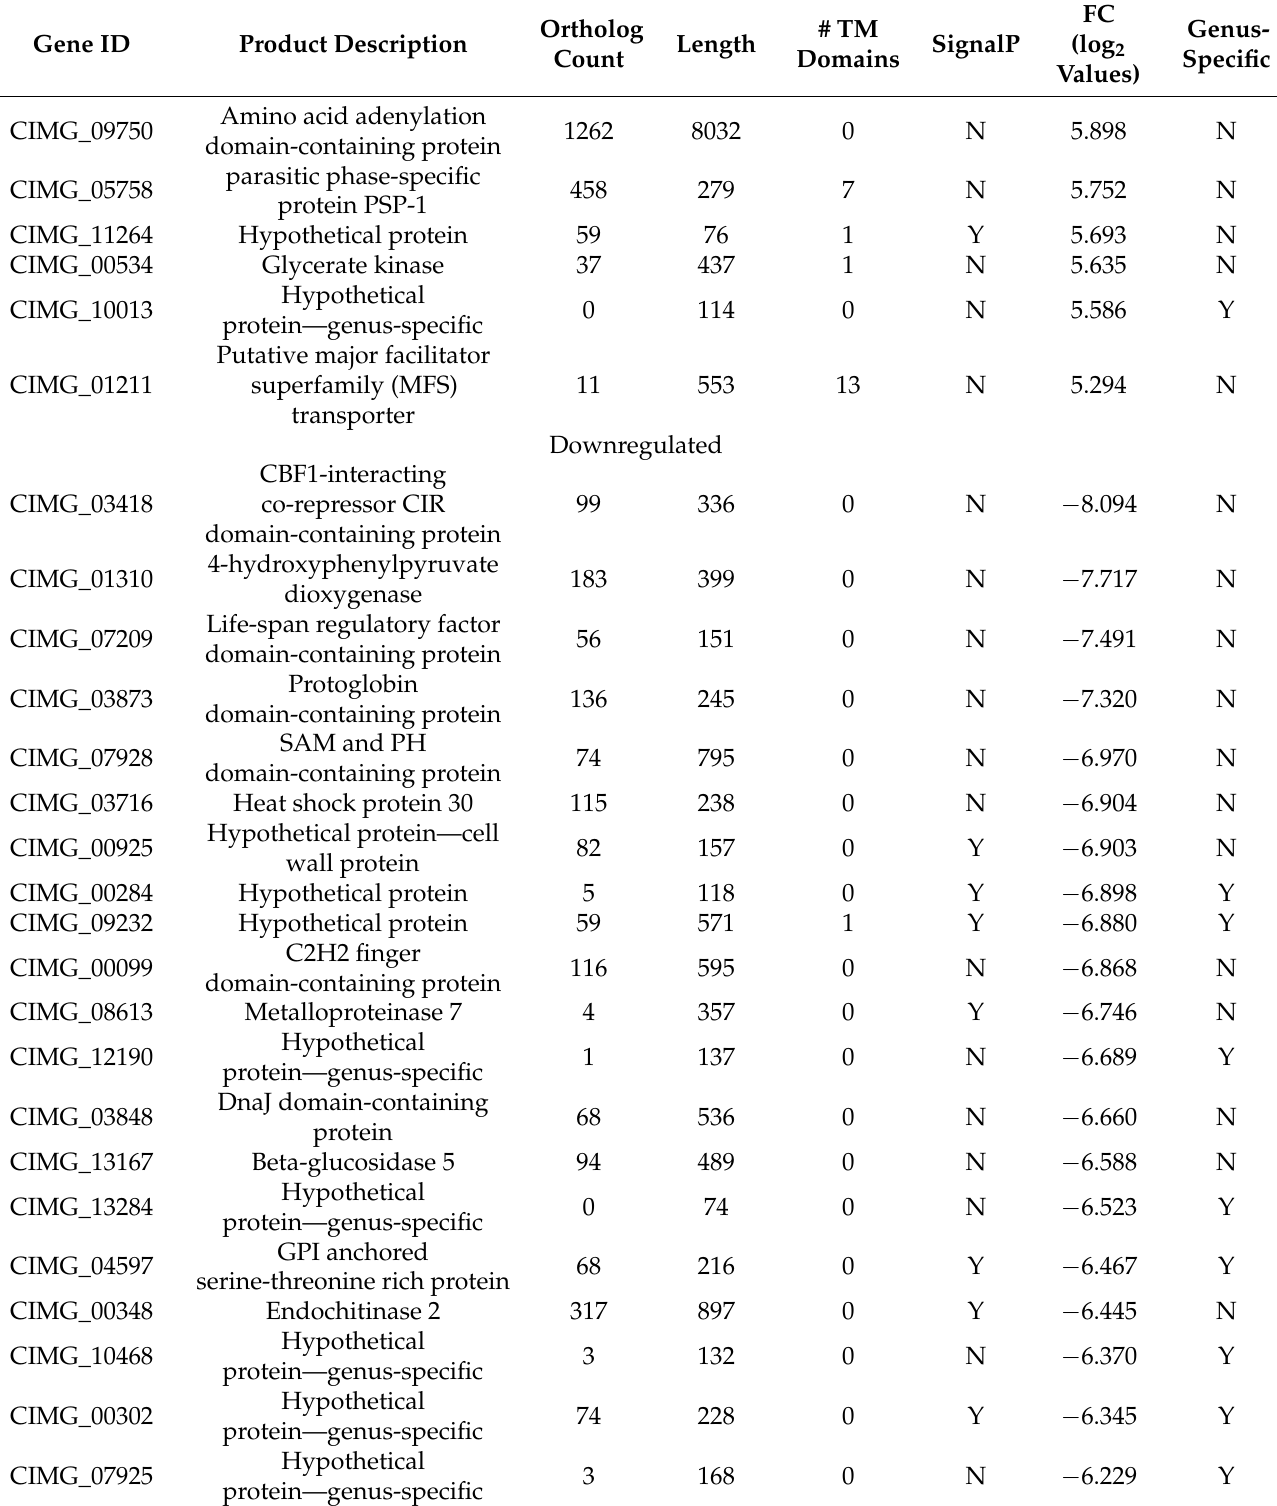
Legend Table 1: The 20 most up- and downregulated genes in young spherules. The gene ID, product description, ortholog count, length, number of transmembrane domains (TM), presence of a signal peptide Yes (Y) or No (N), fold change log 2 expression ratios of young spherules/young spherules and whether the gene is genus-specific Yes (y) No (Y) is shown SOWgp: spherule outer wall